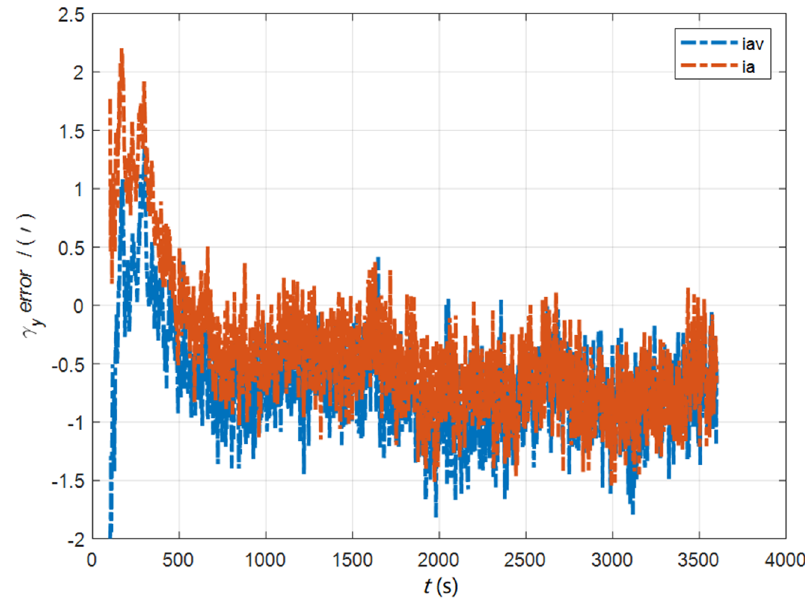
Figure 17. The error curves of γ y in the cases of the initial misalignment angles [ 0.5 (cid:48) 0.5 (cid:48) 10 (cid:48) ] T .